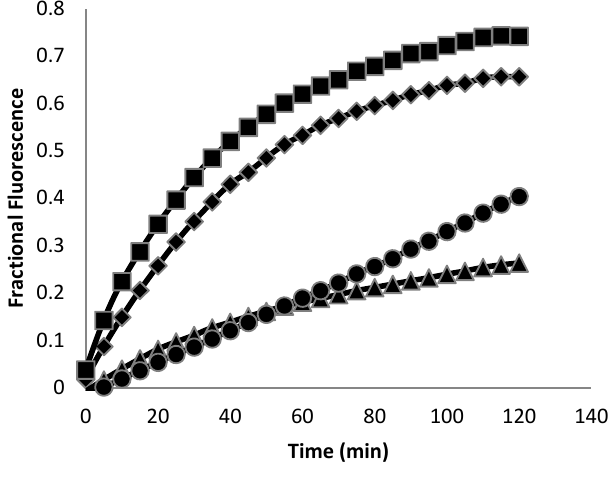
Figure 5. SYTOX uptake into RAW 264.7 macrophages. Peptides were at concentrations equal to four times their MIC values for S. aureus . Diamonds represent CM15 (2